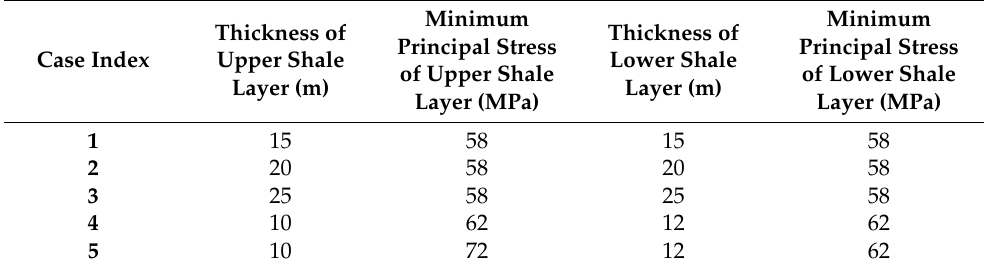
Table 4. Formation properties of the five cases. (‘Stress’ refers to the minimum principal stress.) The stage index refers to the sequence of injected